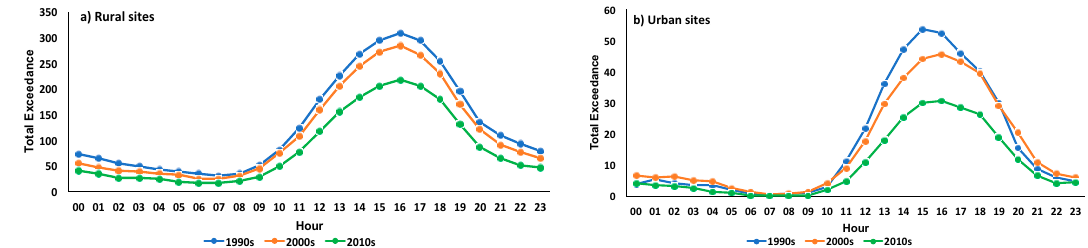
Figure 5. Hourly total ozone exceedances in ( a ) rural and ( b ) urban sites averaged for the decades of the 1990s, 2000s and 2010s. Total exceedance is calculated as the total number of hours at an ozone concentration ≥ 50 ppbv for each hour in a day, yearly averaged for each decade.